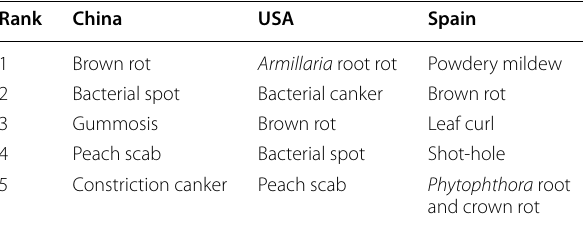
Table 1 Top five peach diseases in order of economic importance as judged by the authors